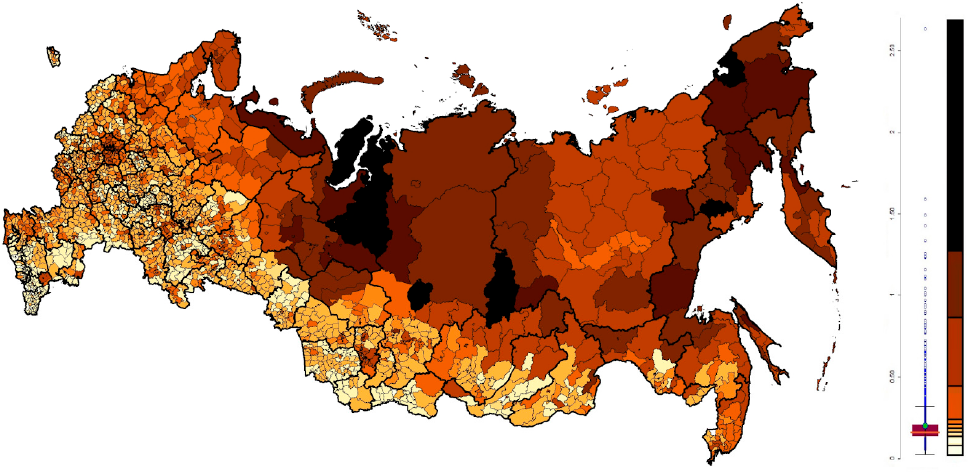
Figure 2. Natural breaks map of average volume of social transfers and population taxable income per capita over 2015–2019 (mln RUB).